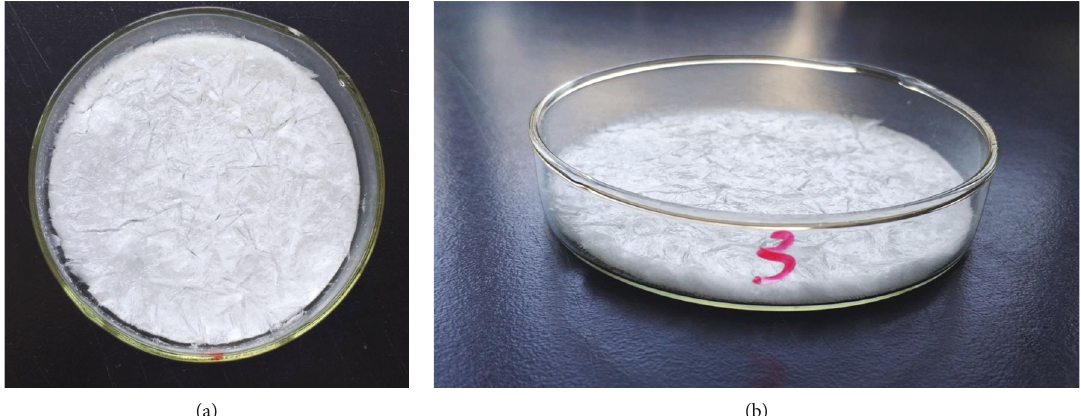
Figure 1: The gross morphology of cellulose composite, a degradable hemostatic